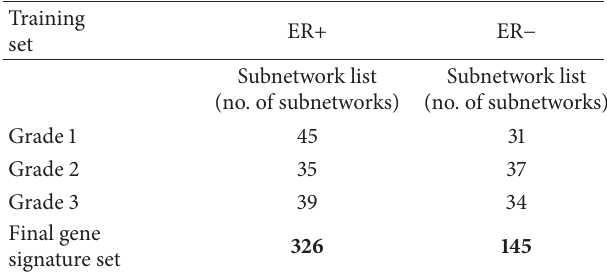
Table 2: RRHGE gene signature size.